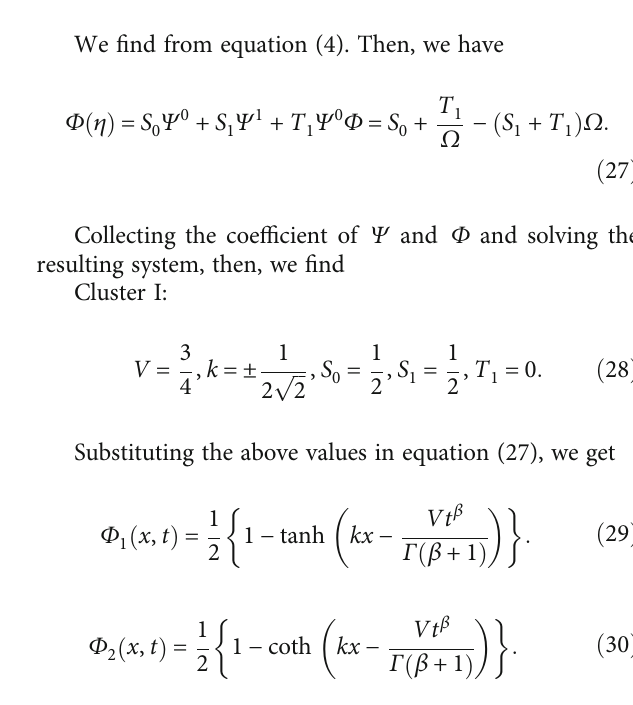
Figure 5: The graphical representation of the solution Φ real contour plot, and (d) imaginary contour